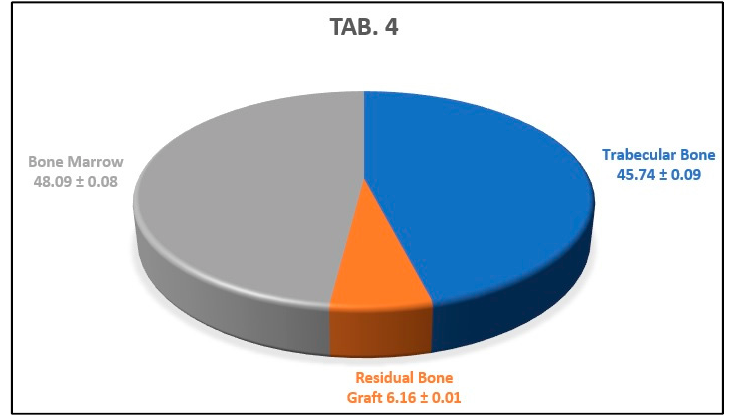
Figure 15. This graph shows the average percentages of newly formed bone, bone marrow, and biomaterial granules of the analyzed sample.